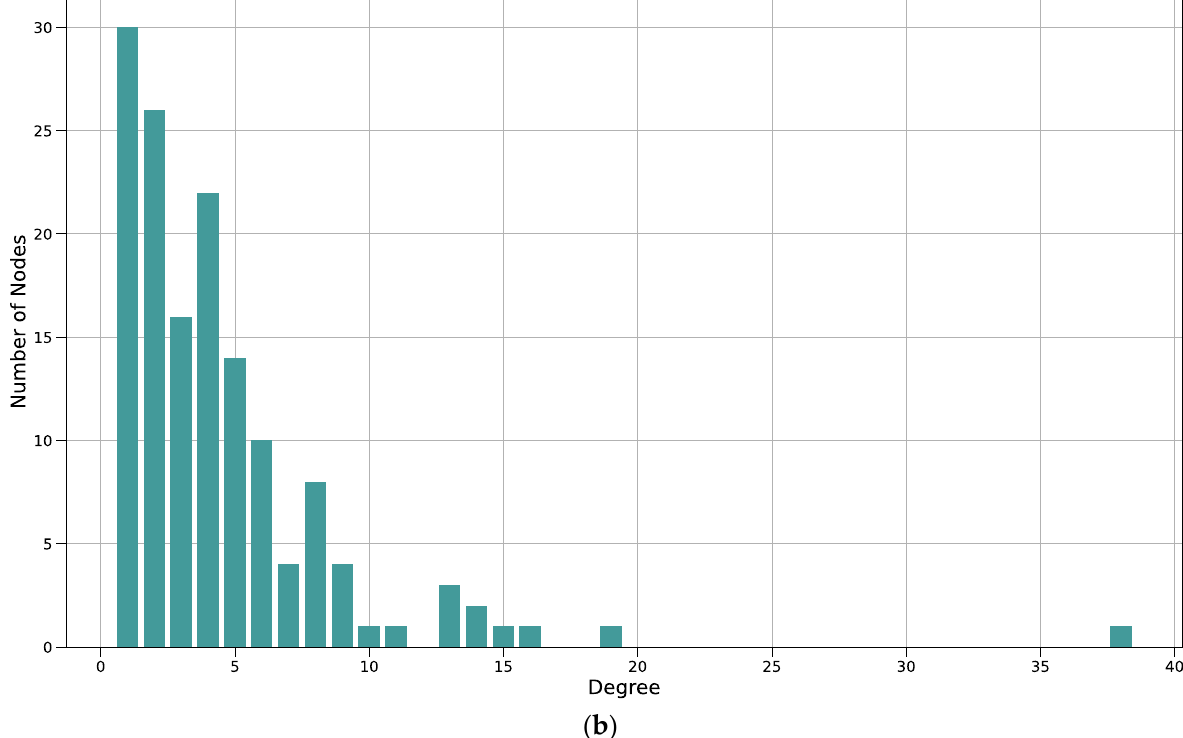
Figure 3. Protein–protein interaction network and degree distribution of the manual CFTR map. ( a ) Each node represents one protein, each edge between them a physical interaction shown in a small-scale study and reported on BioGrid. The larger a node, the higher its degree (i.e., the more interactions it shares with other proteins). CFTR and the five proteins with the next-highest degree are marked in yellow. The color of the protein represents its betweenness centrality, which is a measure of how important the node is to the flow of information through the CFTR Lifecycle Map. The betweenness centrality of a protein is the number of times it lies on the shortest path between two other proteins. The darker the node, the higher its betweenness centrality; ( b ) bar plot of the degree distribution of the protein–protein interaction network in A. The x-axis shows the degree of a protein; the degree is the number of other proteins a protein interacts with. The y-axis shows the number of proteins in the network with a certain degree. For example, the number of proteins that interact with only one other protein in the network (i.e., have a degree of 1) is 30, the number of proteins that interact with six other proteins is ten. The node with the highest degree (38) is CFTR.